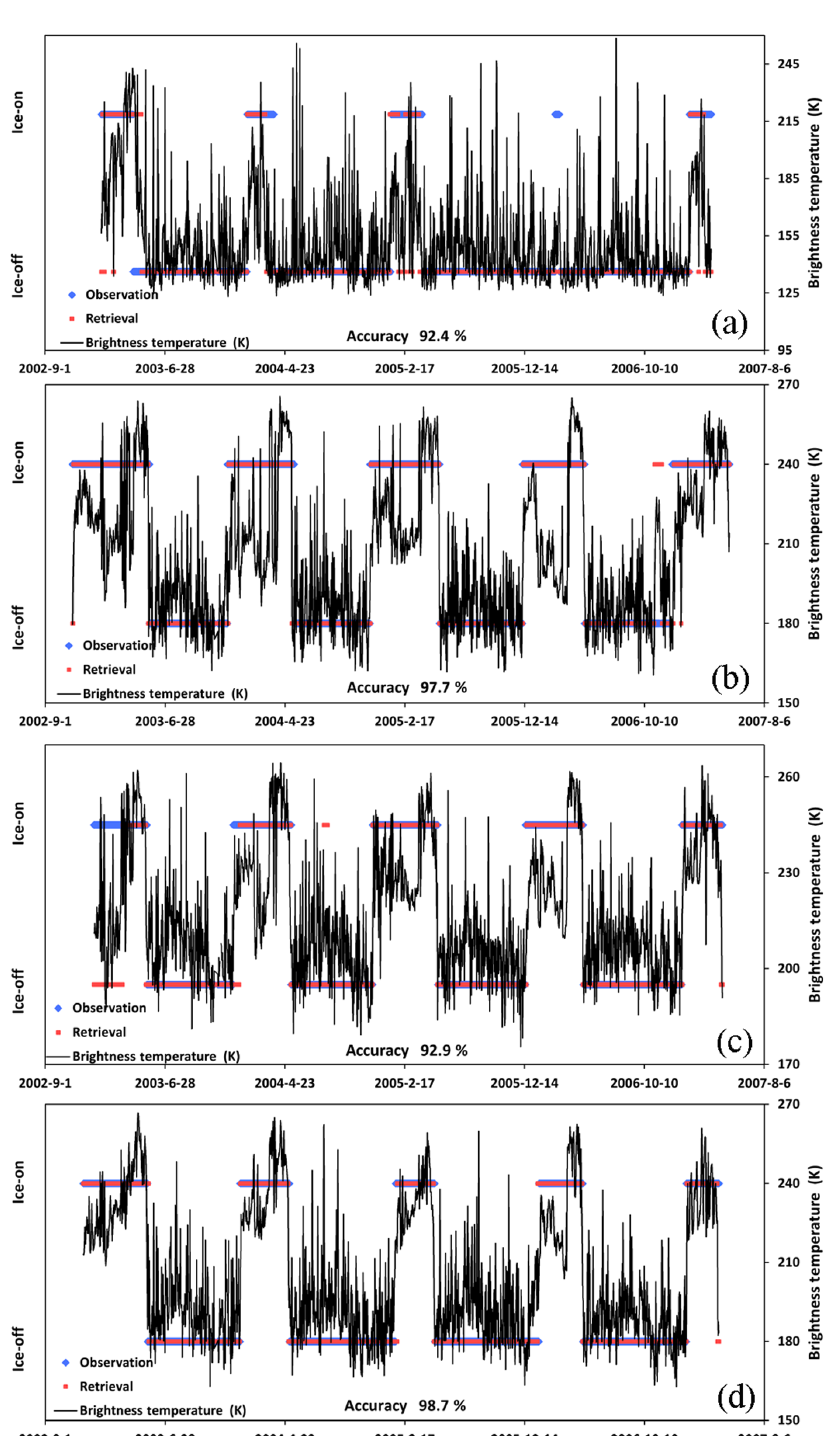
Figure 2. Comparison of lake ice status for Lake Superior, USA and Canada (a) , Lake Oulujarvi, Finland (b) , Lake Haukivesi, Finland (c) , and Lake Paijanne, Finland (d) , derived from the Global Lake and River Ice Phenology Database (GLRIPD) (blue dots) and AMSR Lake Ice Phenology retrievals (LIP) (red dots). The AMSR-E/2 36.5GHz H-polarized daily T b retrievals used in the LIP algorithm are also plotted for reference (black line). The blue/red dots represent GLRIPD/LIP-derived ice conditions as indicated by their y axis positions for the dates described by their x axis